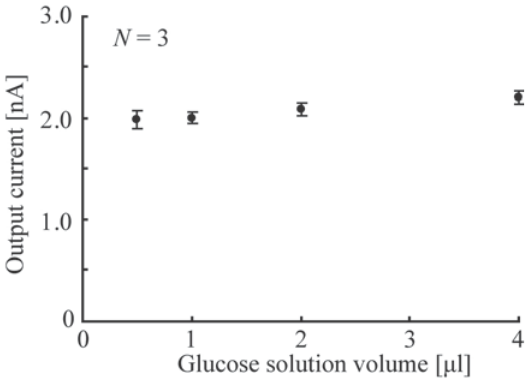
Figure 5. Relationship between the glucose solution volume and the output